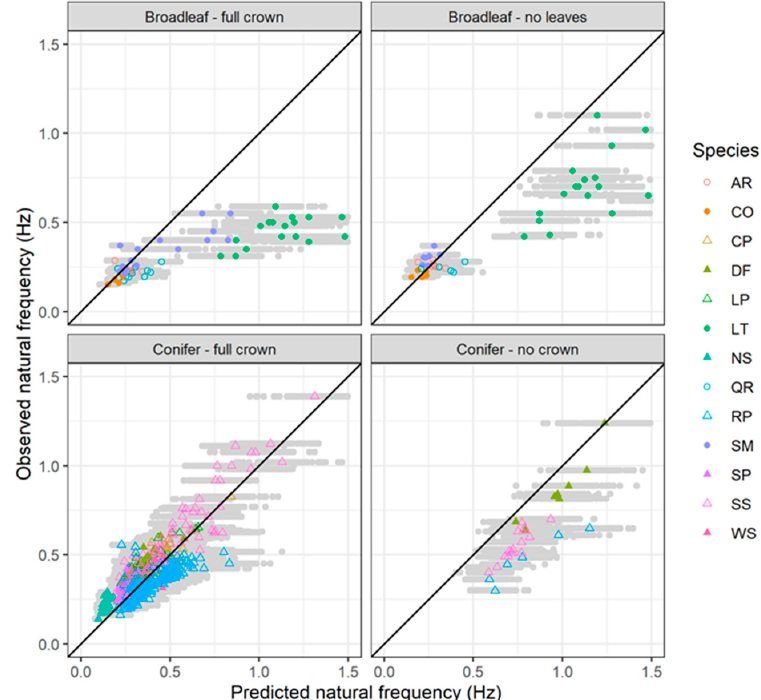
Figure 11. Comparison between predicted natural frequency and observed natural frequency for selected trees from the published literature. The grey points show the range of simulated values and the coloured symbols represent the mean result for each tree. The solid black line indicates a 1:1 relationship.